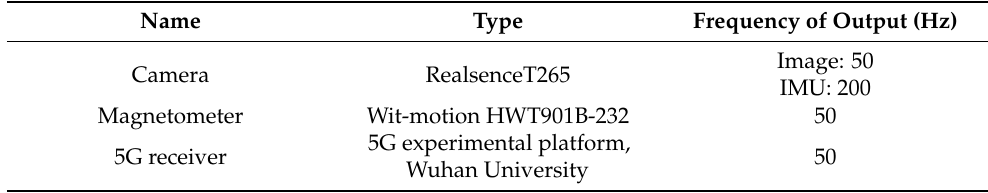
Figure 9. Experimental installation. Table 1. Experimental equipment parameters.